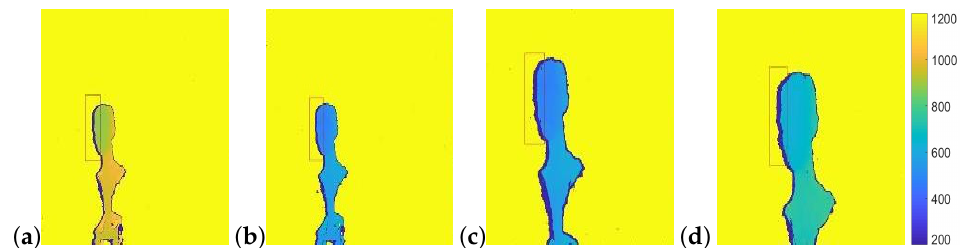
Figure 20. Manipulating depth images. ( a ) Original depth image. Object and background distances from camera are 900 mm, and 1340 mm. Shadow width is calculated as 11.675 pixels and measured 12 pixels. ( b ) Object depth values have been scaled to 500 mm. Shadow width is now calculated as 40.11 pixels with shadow width in image, remaining 12 pixels. ( c ) Object depth values have been scaled to 500 mm and the object re-sized consistently. The shadow width is now calculated as 40.11 pixels and measured width is 25 pixels. ( d ) Depth values have been scaled to 500 mm and the object re-sized to correct for the shadow width. Shadow width now measures 40 pixels in the image. The head, however, now corresponds to a head size of 230 mm, which is much larger than a human